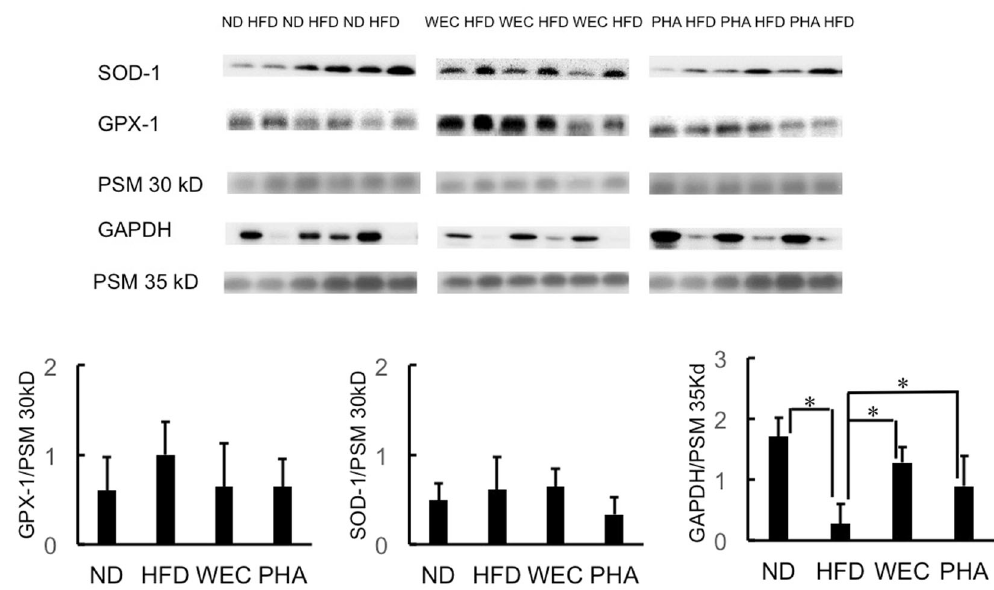
Fig. 5 The effects of WEC and PHA on hepatic protein levels. Hepatic protein levels of SOD-1, GPX-1, and GAPDH in the normal diet-fed (ND), high-fat diet-fed (HFD), Chlorella pyrenoidosa water extract-treated (WEC), and phenethylamine-treated (PHA) groups. Data are represented as mean ± standard deviation ( n = 6). The means were compared using analysis of variance, followed by Dunnett ’ s test. * p < 0.05 vs. HFD group. PSM, pre-stained marker.